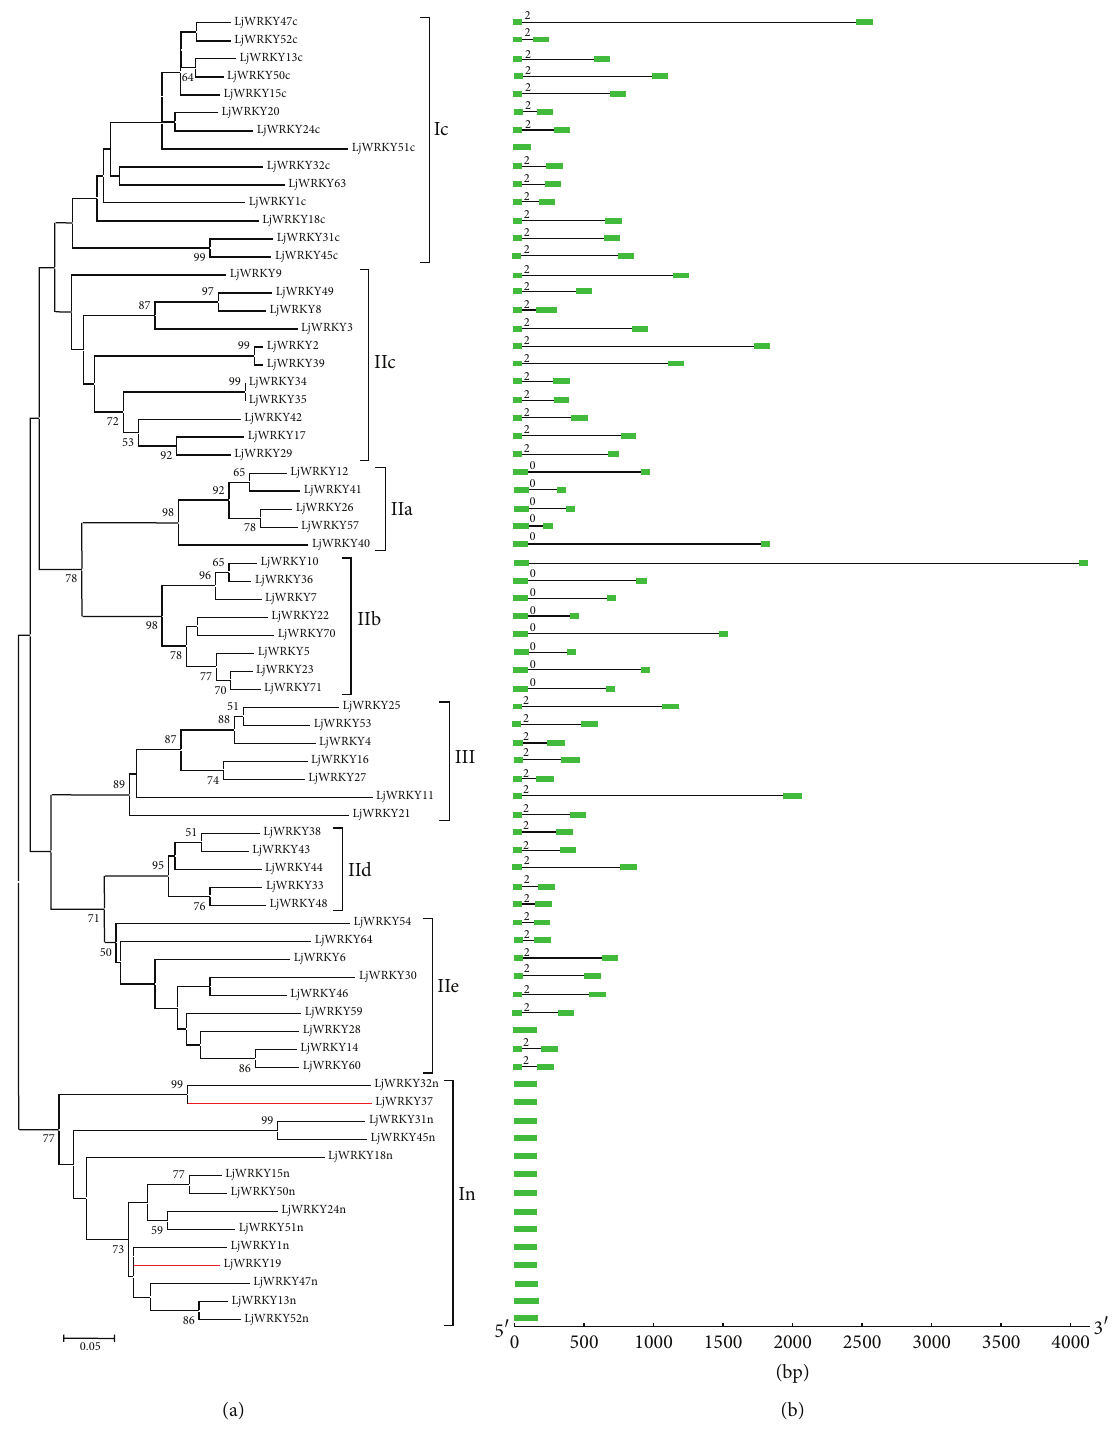
Figure 4: Phylogenetic relationships and gene structure of Lotus japonicus WRKY domains. (a) Multiple alignments of WRKY domain amino acids executed by Clustal W and the phylogenetic tree constructed using MEGA 4.0 by the Neighbor-Joining (NJ) method with 1,000 bootstrap replicates. The red line indicated group IIx member. The percentage bootstrap scores higher than 50% were indicated on the nodes. (b) Exon-intron structures of WRKY domain genes from Lotus japonicus . Exons and introns were represented by green boxes and black lines, respectively. The number indicated introns phases. The sizes of exons and introns can be estimated using the scale at the